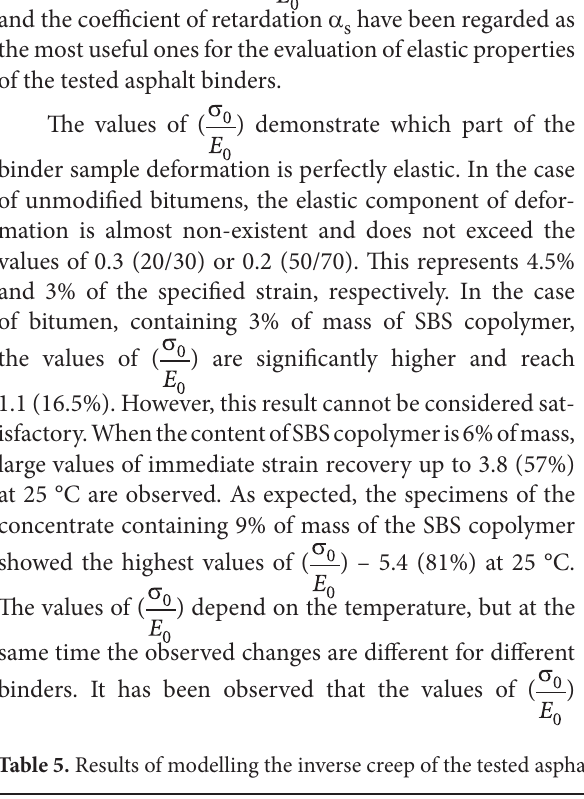
Table 5. Results of modelling the inverse creep of the tested asphalt binders T Asphalt binder